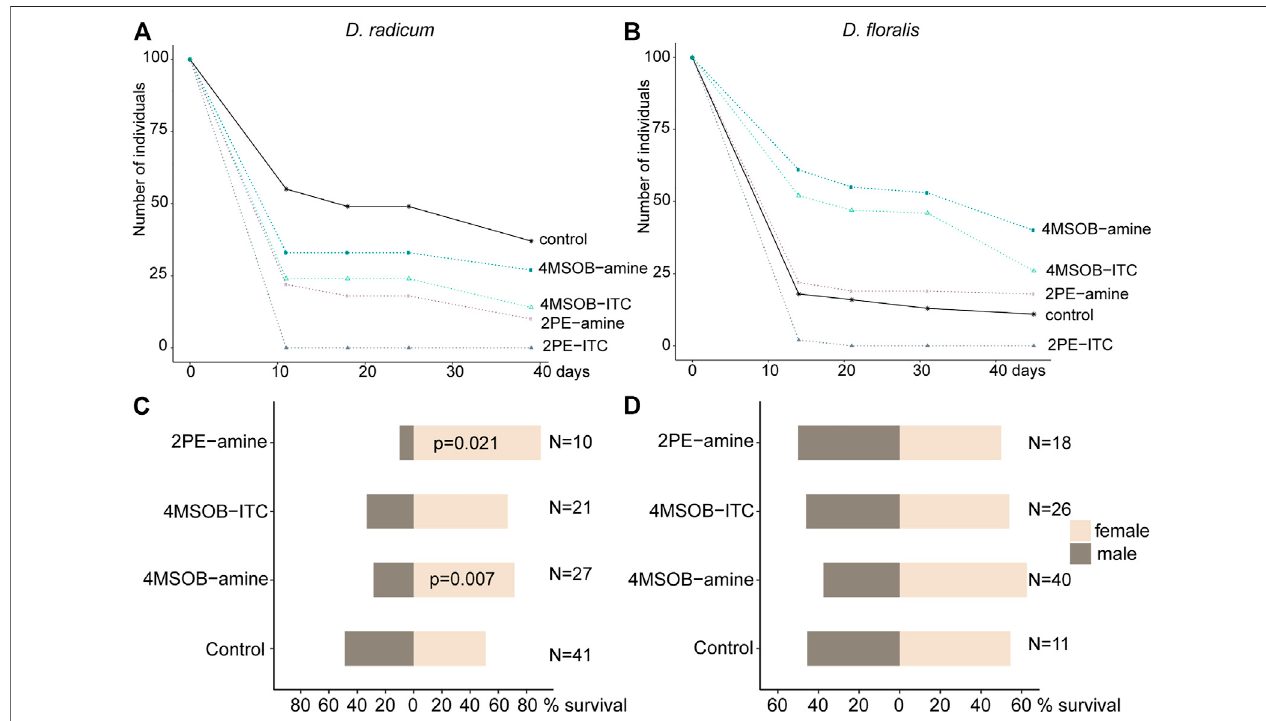
FIGURE6| Effects ofisothiocyanates(ITCs)andamineson Deliaradicum and D. fl oralis performance.Larvaewerefedonasemi-arti fi cialdiet(control)orthesame diet spiked with 2 μ mol/g diet of 2-phenylethyl isothiocyanate (2PE-ITC), 2PE-amine, 4-(methylsul fi nyl)butyl isothiocyanate (4MSOB-ITC), or 4MSOB-amine per g diet. (A) Survival of D. radicum and (B) D. fl oralis over 40 days are presented as Kaplan-Meier curves. (C) Male-female ratios in the resulting D. radicum and (D) D. fl oralis adults compared using a one-proportion z -test. Signi fi cant p -values below 0.05 are included in fi gure. N = number of males and females.